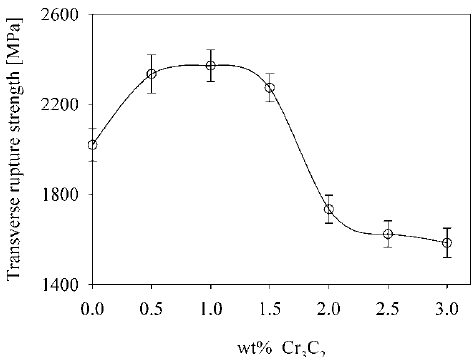
Figure 6. Effect of the Cr 3 C 2 addition on the transverse rupture strength of the WC-10Co cemented carbide.